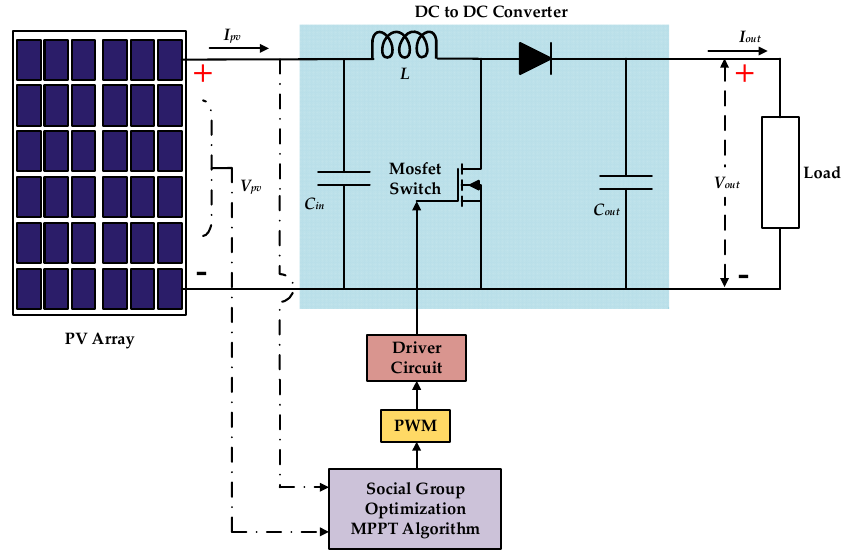
Figure 7. Solar DC–DC converter-integrated SGO–MPPT control.